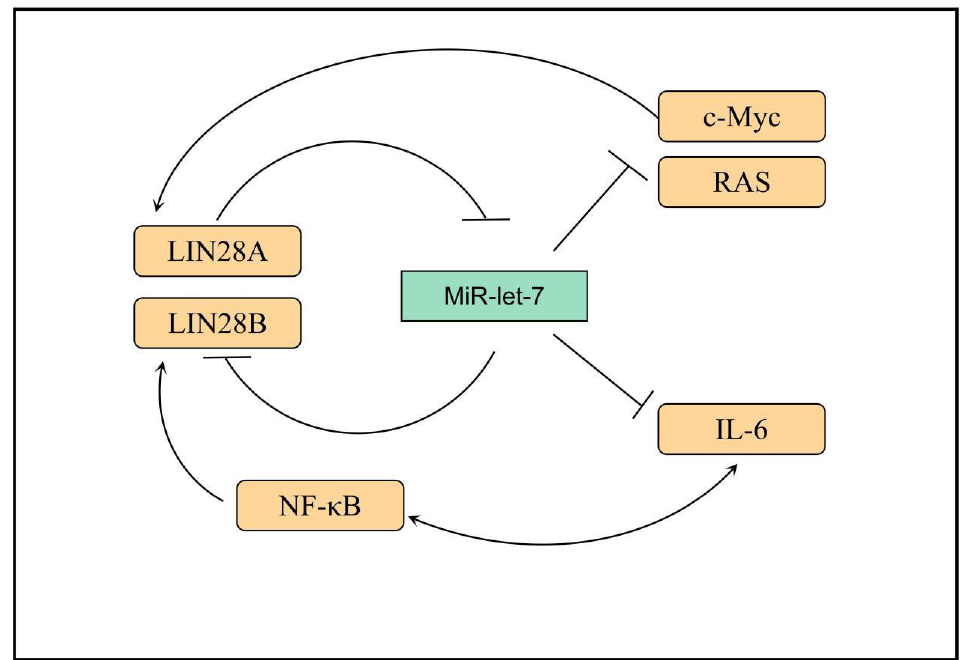
Figure 1. Transcriptional networks that regulate LIN28B expression. LIN28B expression is lost. In adult mammals, only a small subset of somatic cells exist where LIN28B expression occurs. Several transcription factors, such as MYC and NF- κB , promote LIN28B transcription, while REST and ESE3/EHF are transcriptional repressors. IL-6: interleukin-6, RAS: Resistance to audiogenic seizures, NF- κB : nuclear factor kappa-B, MYC: MYC protooncogene.